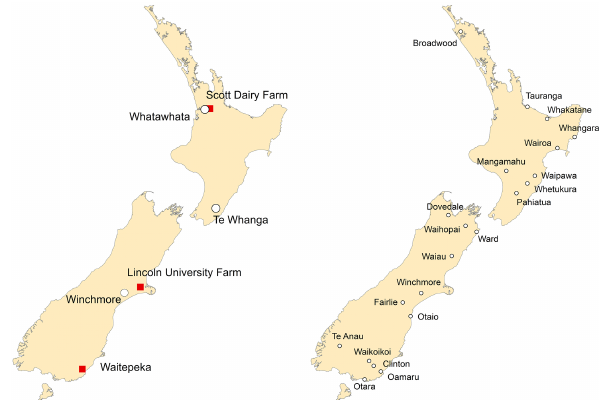
Figure 1. Calibration and validation sites. Left: dairy and sheep/beef calibration sites. White circles are sheep/beef sites, and red squares are dairy sites. Right: sheep/beef validation sites. The three most northern sites (Broadwood, Tauranga, and Whakatane) are outliers in terms of model–observation